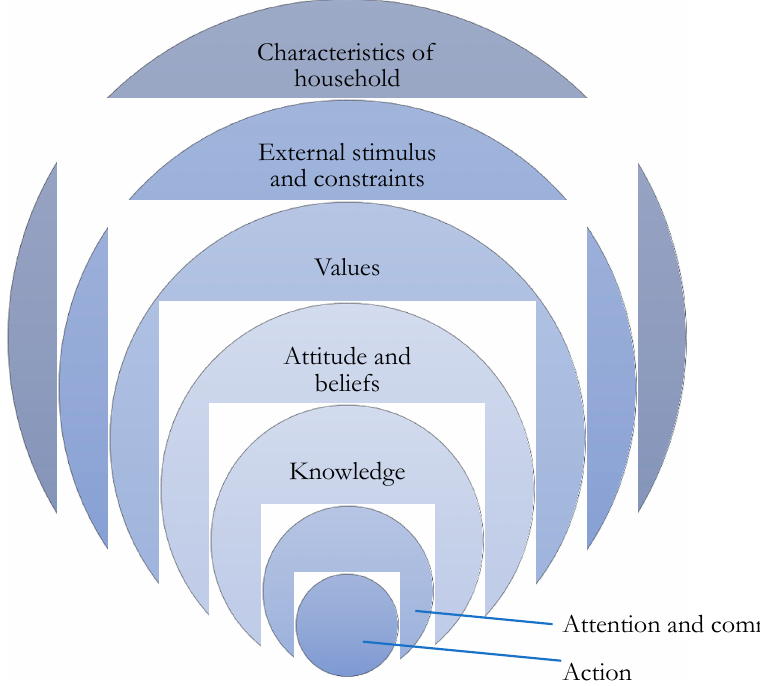
Figure 4. Attitude–behavior–context model for energy efficiency implementation in the residential sector (adjusted from (Stern and Oskamp, 1987)).